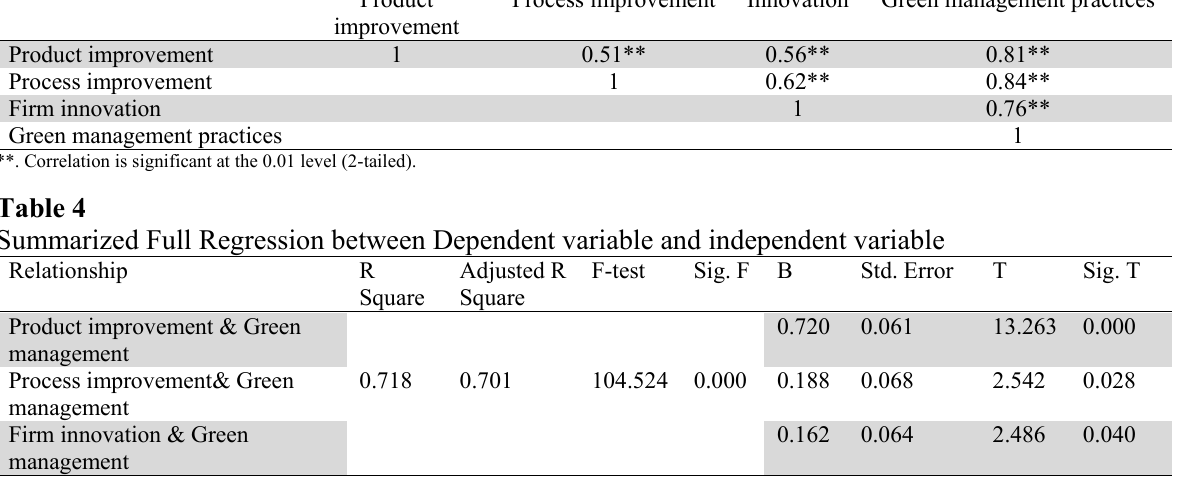
Product Process improvement improvement